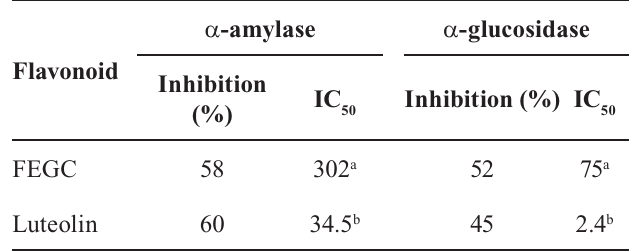
TABLE I - I nhibitory activity of FEGC and luteolin against α -amylase and α -glucosidase